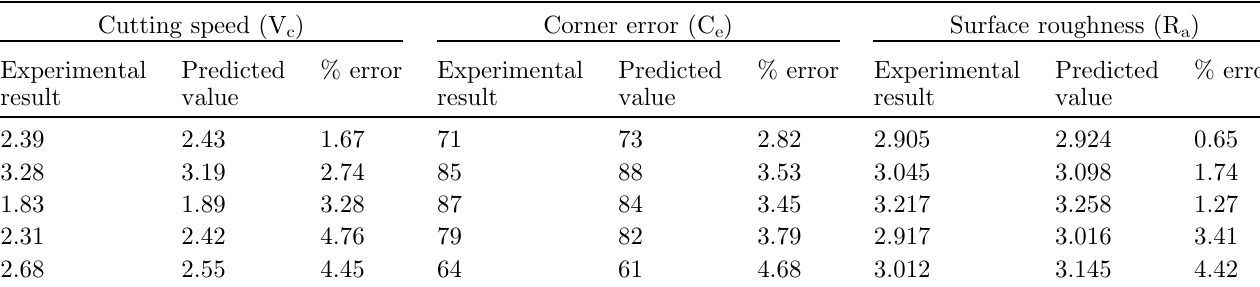
Table 7. Comparison between experimental results and model prediction values. ) Cutting speed (V c